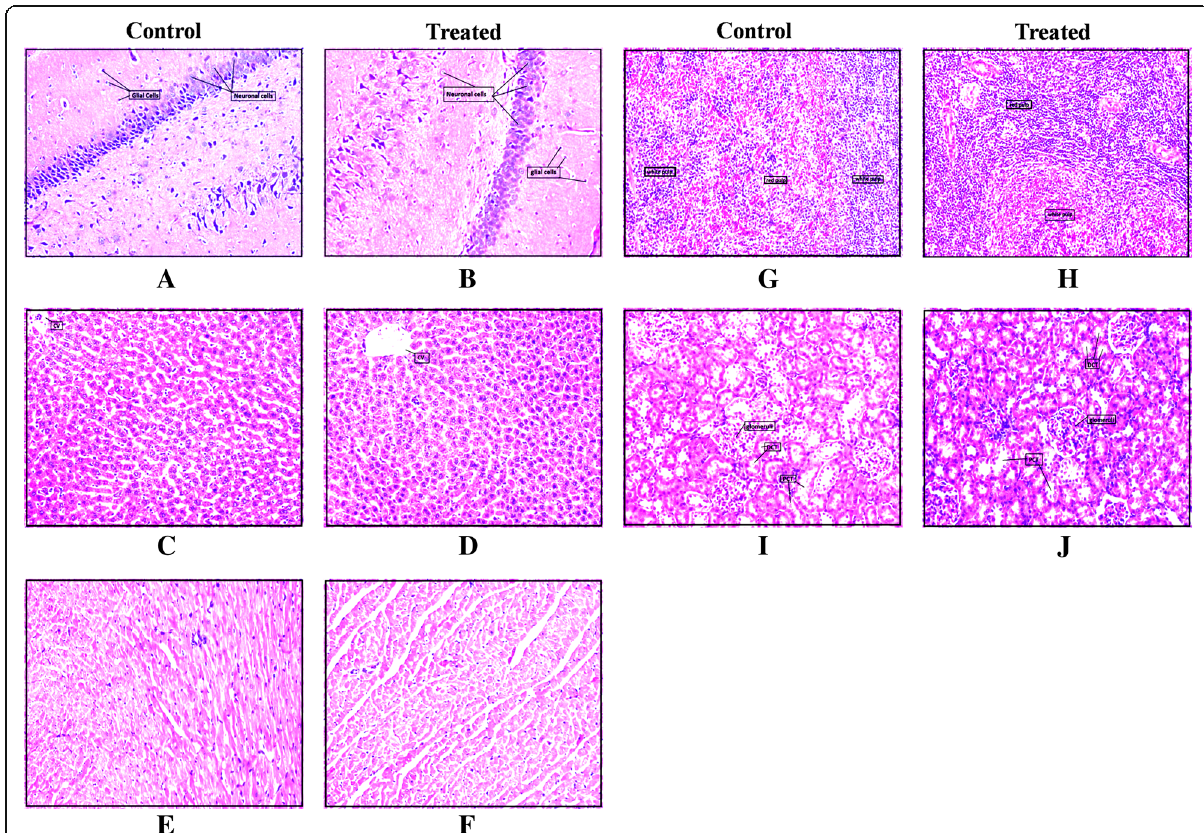
Fig. 5 Effect of 1000 mg kg − 1 of Asdamarin on histology of vital organs of male rats. a and ( b ): brain; ( c ) and ( d ): liver; ( e ) and ( f ): heart; ( g ) and ( h ): spleen; ( i ) and ( j ): kidney. cv, central vein; DCT, distal convoluted tubule; PCT, proximal convoluted